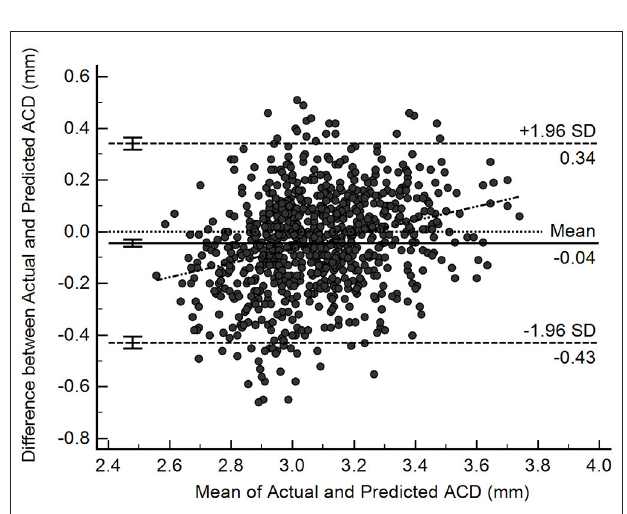
FIGURE 3 | Bland-Altman plots illustrating agreement between deep learning-predicted and actual anterior chamber depth (ACD) measurements from Lenstar ( n =